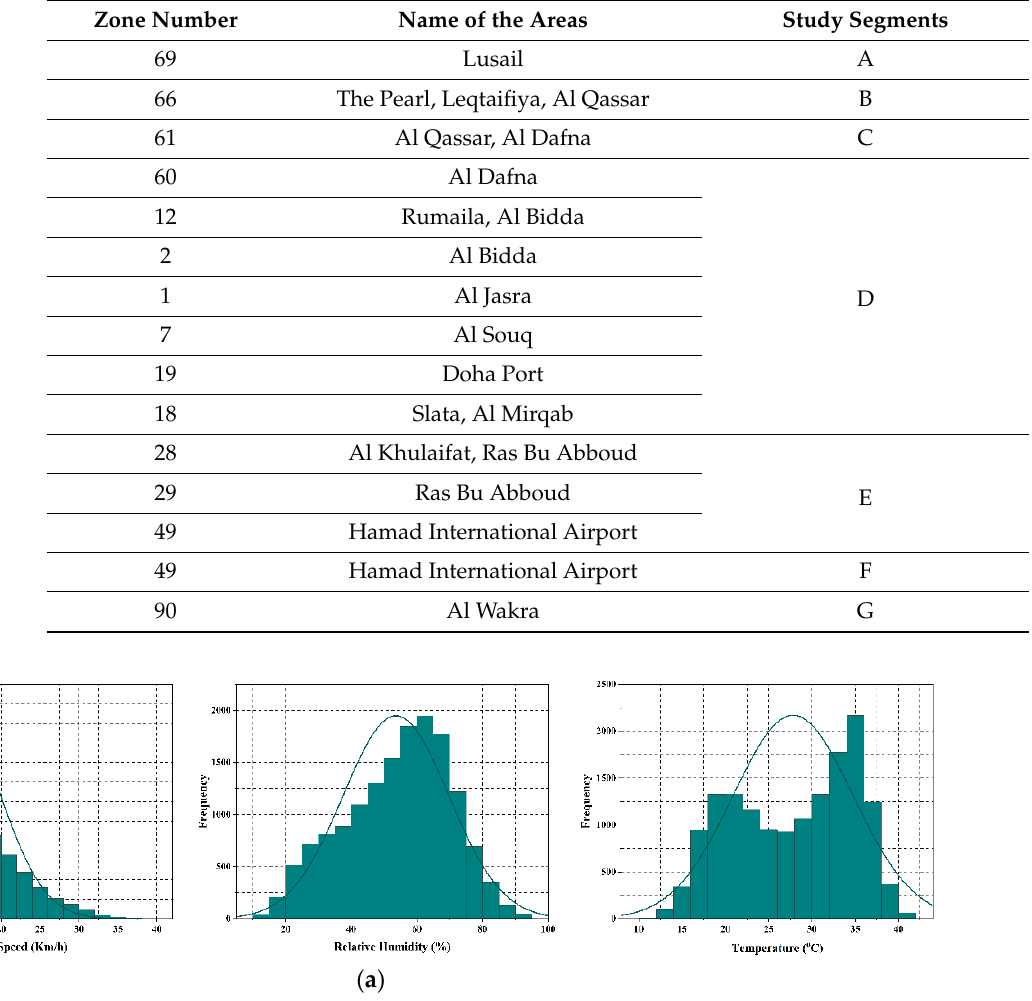
Table 1. Zone number and its allocated areas.